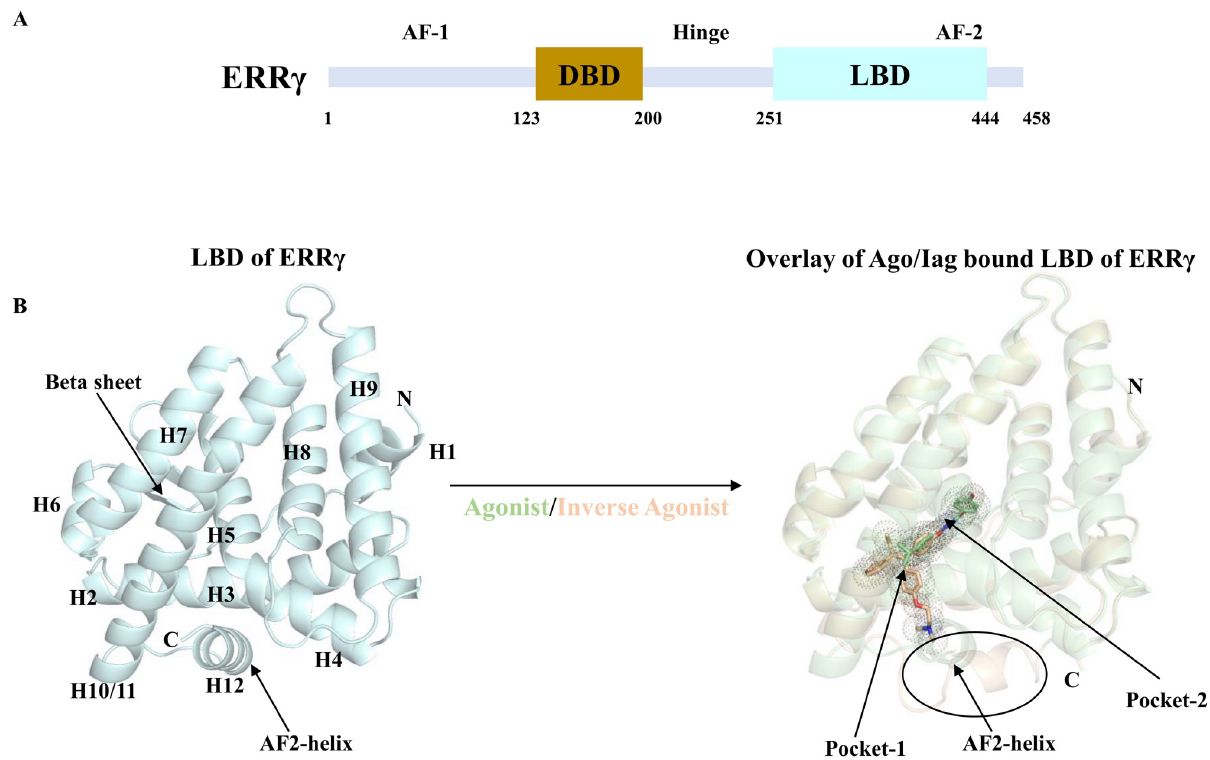
Fig 1. Domain organization and structure of ERR γ (A) The full-length domain organization of ERR γ . (B) Ligand-binding domain (LBD) structure of ERR γ which comprises of 12 helices and a β -sheet (left). Agonist- (pale green color) and inverse agonist- (wheat color) bound ERR γ structures are overlaid (right). Ligands are shown in stick representation with their respective pockets shown in dots. AF2-helix conformational differences are shown in the black circle.